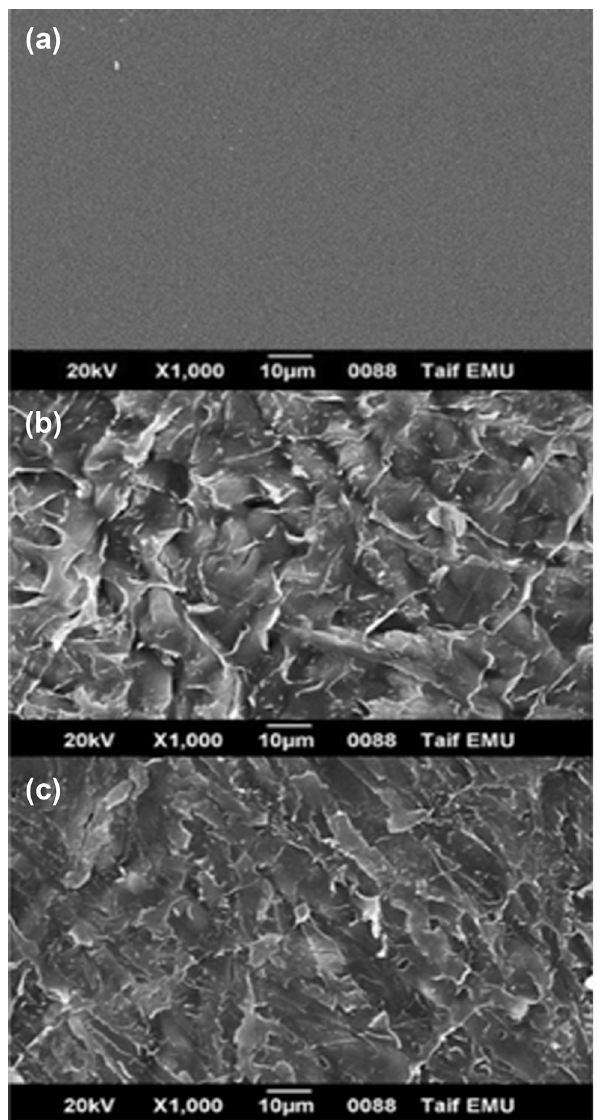
Figure 7: SEM images of ( a ) neat chitosan membrane with a homo - geneous surface, ( b ) chitosan – ZnO membrane with a rough pore - containing surface, and ( c ) chitosan – ZnO/CuO membrane with the highest surface roughness and porosity. Reproduced from ref. [ 129 ]